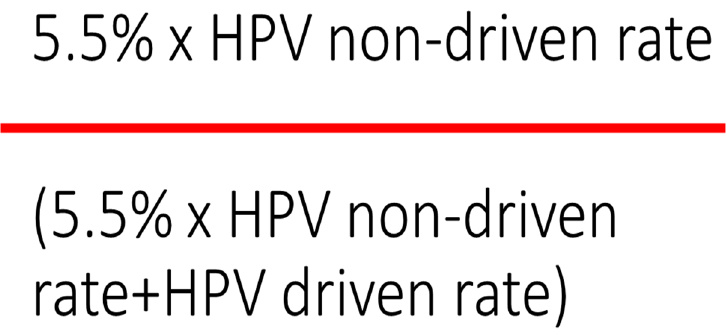
Figure 1. Formula to compute the rate of false positive p16 IHC if the reference is the combination between p16 IHC and PCR of genomic E6/E7.